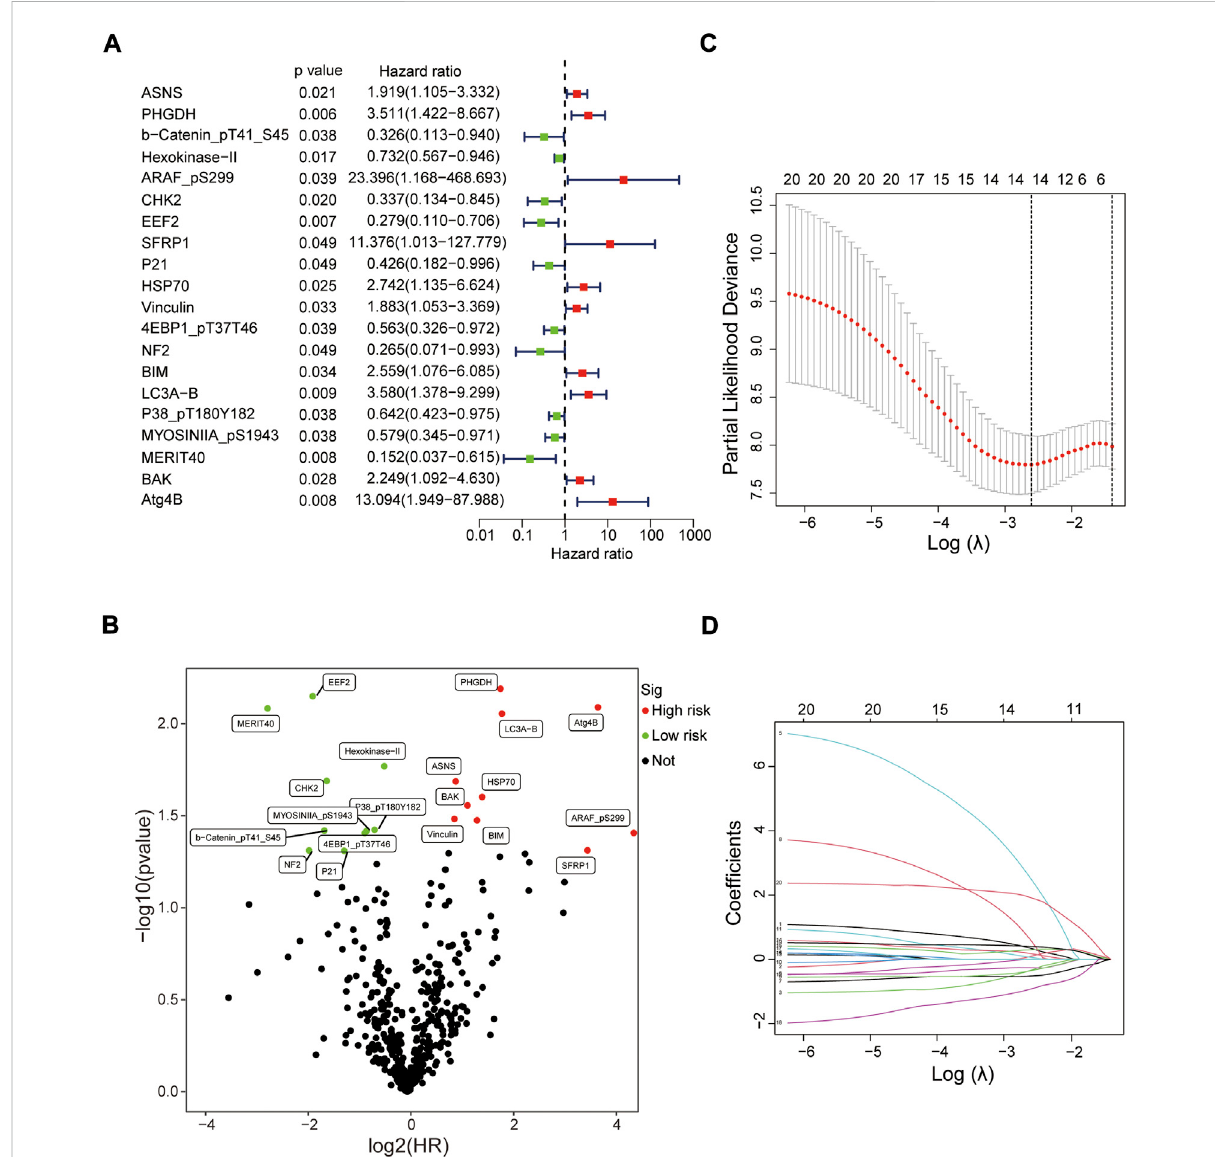
FIGURE 2 Screening prognostic-related proteins in EC from TCGA database. (A) Study of the correlation between 20 prognostic-related proteins and overall survival of EC patients by univariate Cox regression analysis. (B) The upregulated and downregulated prognostic-related proteins in volcano plot. (C,D) The Lasso regression analysis of these 20